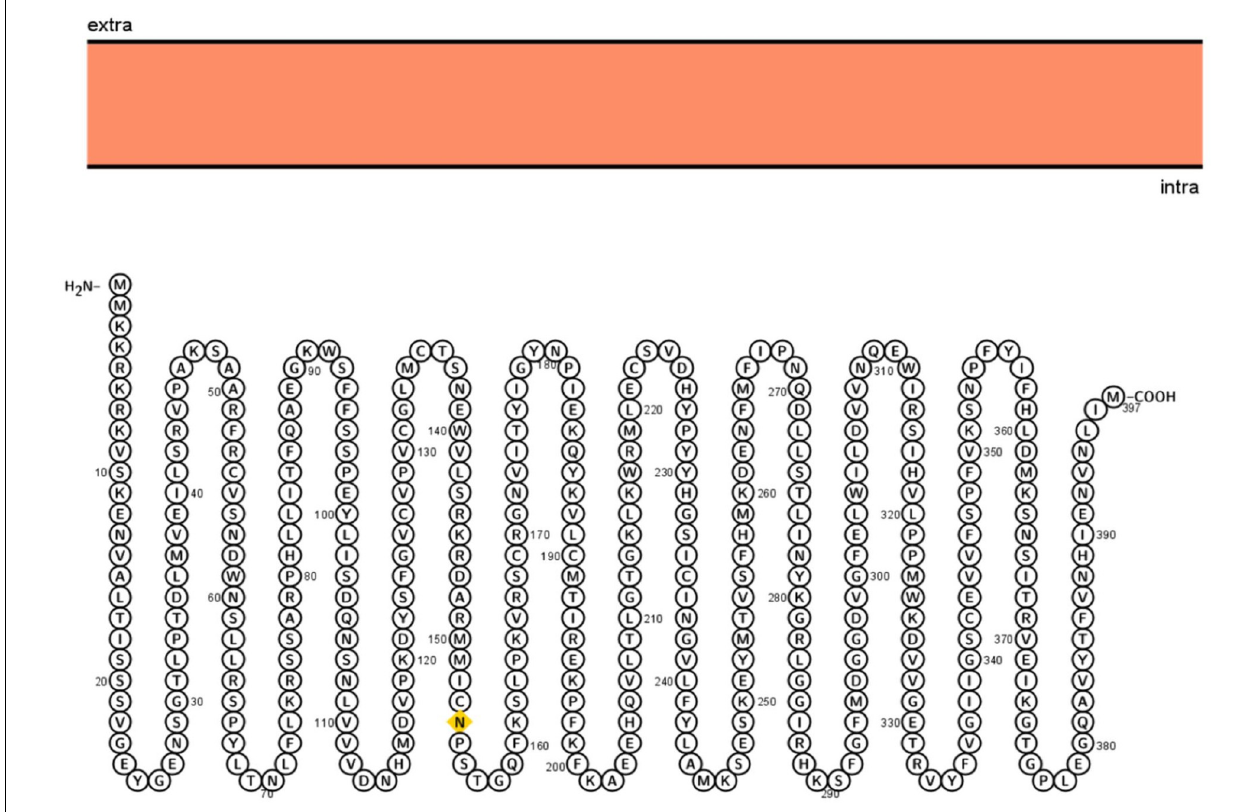
FIGURE 6 | Visualization of 3p.AtFBP113 protein topology. Protter shows that 3p.AtFBP113 is lacking transmembrane helices and is present in the intracellular region. Therefore, it is deprived of the typical topology, which is the characteristic feature of TM proteins. TABLE 1 | Physicochemical properties of 3p.AtFBP113 protein predicted using the ProtParam tool available at the ExPASy server. Parameters Number of amino acids/protein